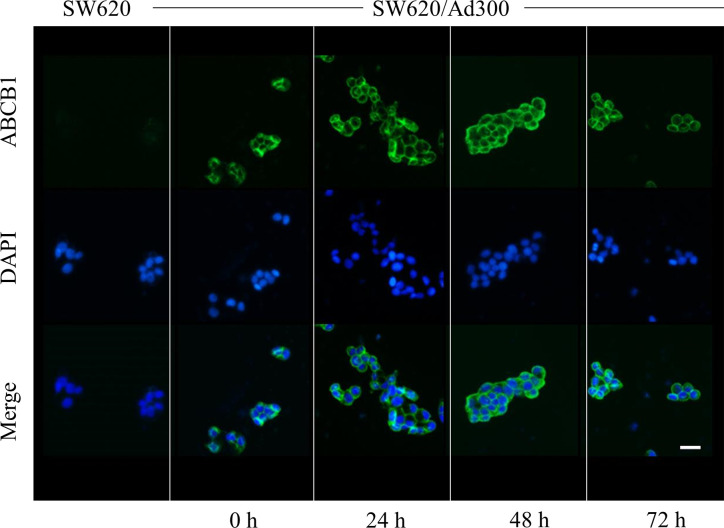
The effect of sapitinib on the cellular location of ABCB1 in SW620/Ad300 cancer cells. ABCB1-overexpressing SW620/Ad300 cells were seeded in 24-well plate and incubated with or without sapitinib (5 µM) for 0, 24, 48 and 72 h. The cells were then fixed using 4% paraformaldehyde at 37°C for 5 min. Subsequently, the cells were blocked using 6% BSA at 37°C for 1 h and co-cultured with the monoclonal antibody C219 at 4°C overnight. The secondary antibody, Alexa Fluor 488 was added to co-culture with the cells and incubated at 37°C for 1 h. After washing with ice-cold PBS, the nuclei were counterstained with DAPI at 37°C for 10 min. An EVOS® FL Auto ﬂuorescence microscope was used to detect and capture the immunoﬂuorescence images. SW620 cells were used as a negative control.